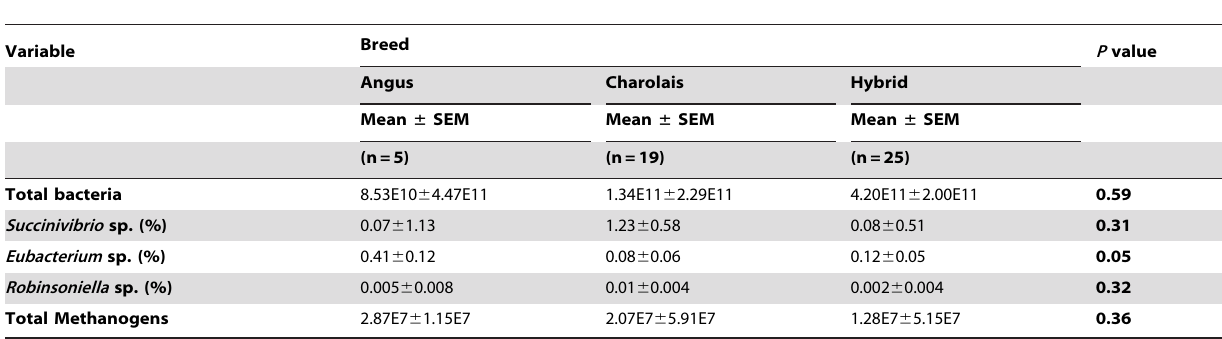
Table 7. Particular bacterial species and methanogen population in steers differing breed (n=49) in HE.